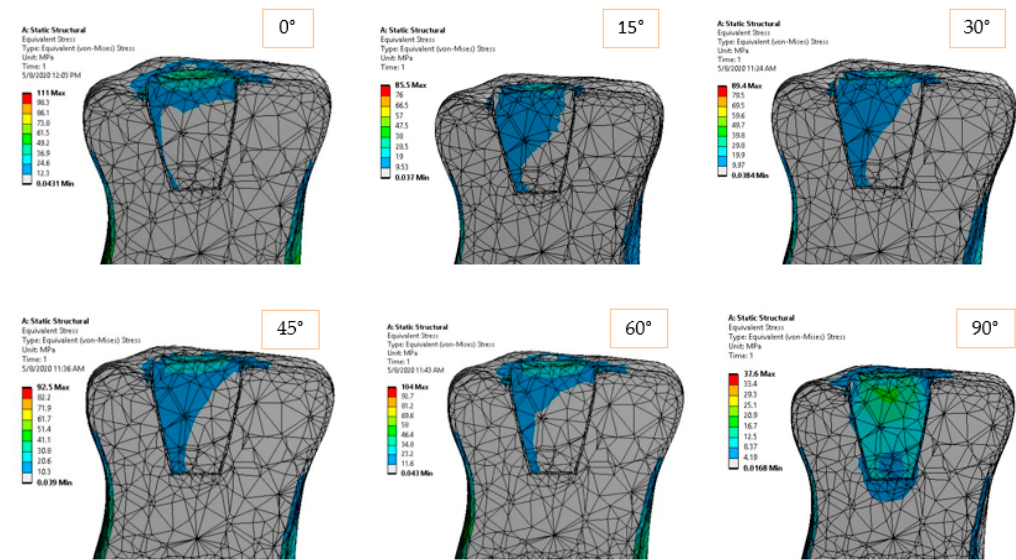
◦ –90 ◦ loading direction. Figure 6. Equivalent elastic stress for 170 N load and 0°–90° loading direction.